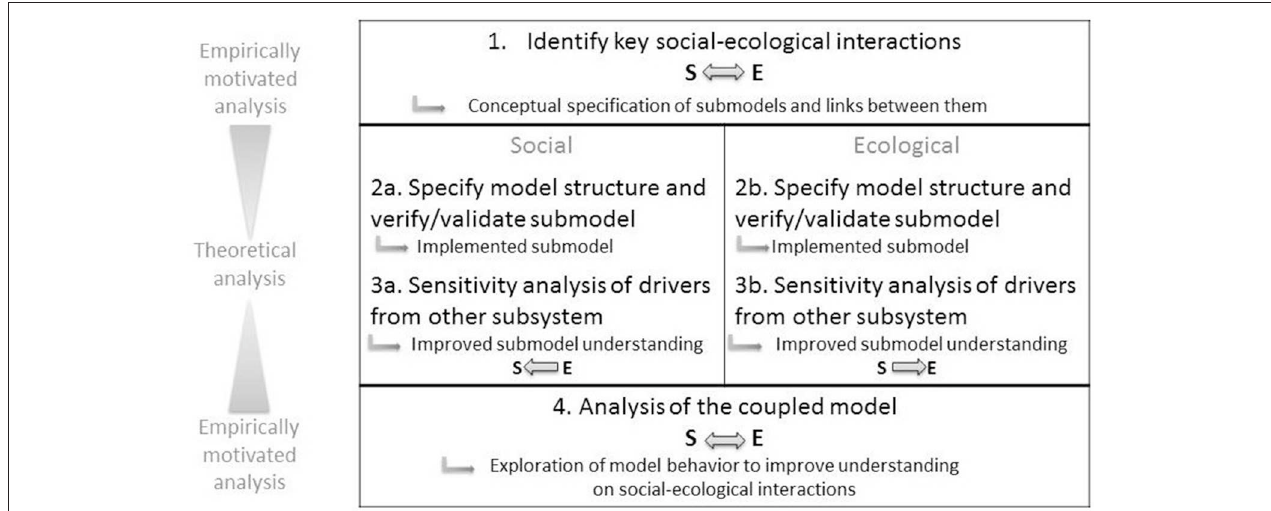
FIGURE 1 | Main steps for developing and analyzing a hybrid model for a SES.